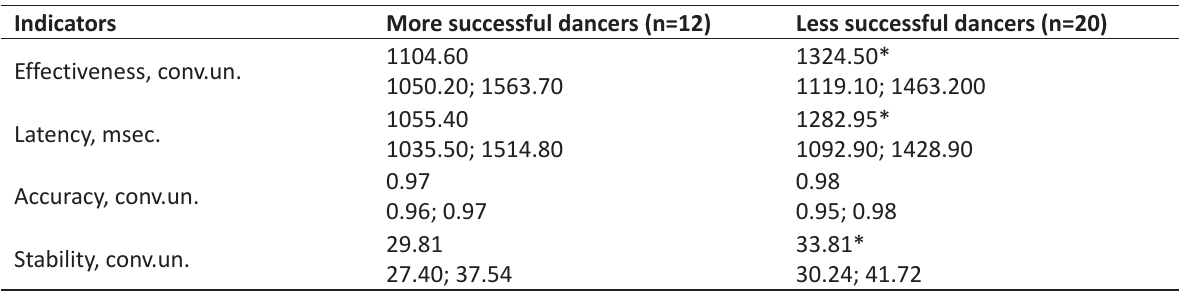
Table 2. Indicators of cognitive test for verbal irritators “recognition of regularities” in dancers with different successfulness (median, top and bottom quartiles) Indicators More successful dancers (n=12) Less successful dancers (n=20) Efficiency, conv. un. Quickness, conv. un. Accuracy, conv. un. Effectiveness, conv. un.